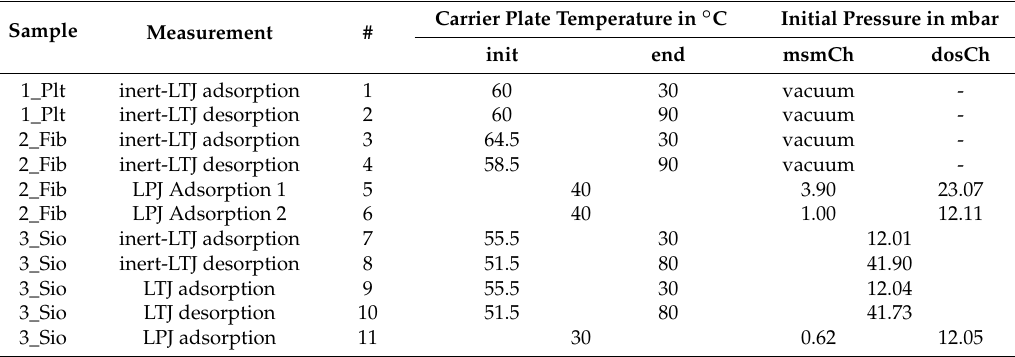
Table 3. Measurement initial conditions. LPJ, large pressure jump.